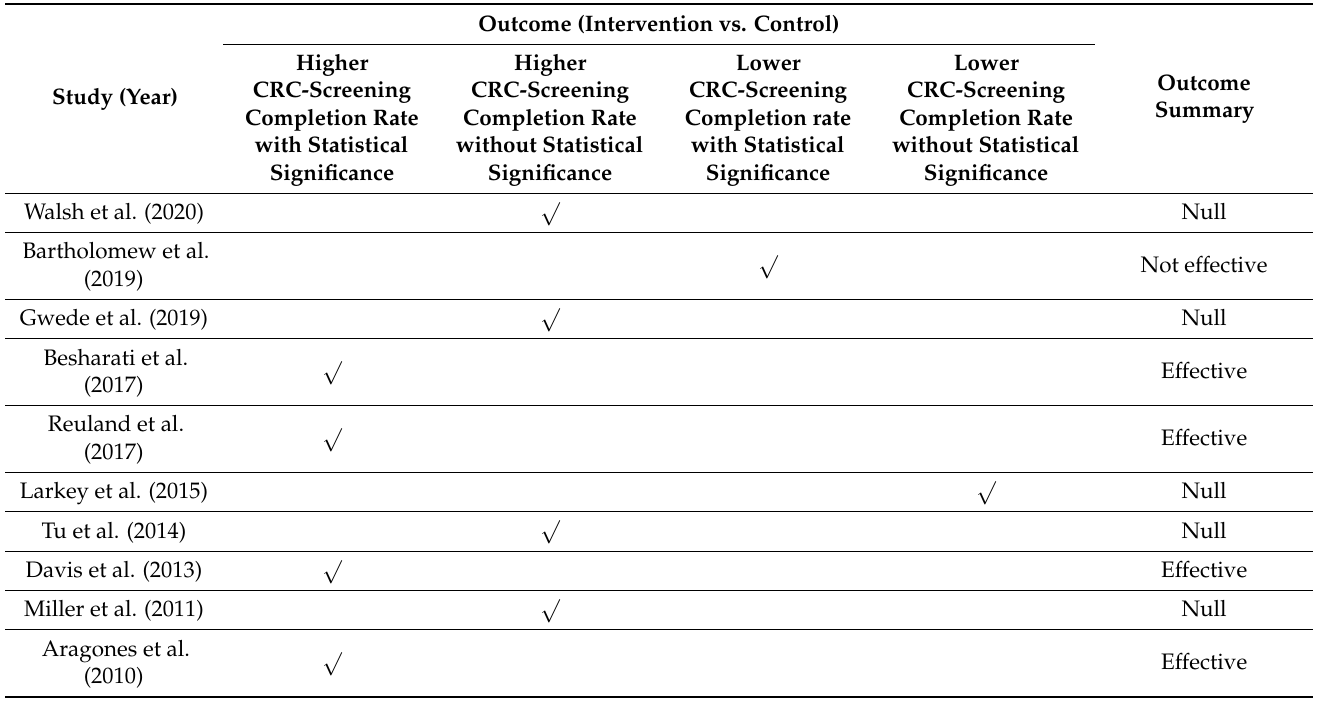
Table 3. Outcome summary for CRC-screening completion rates using e-media interventions ( N = 10). Outcome (Intervention vs. Study (Year)